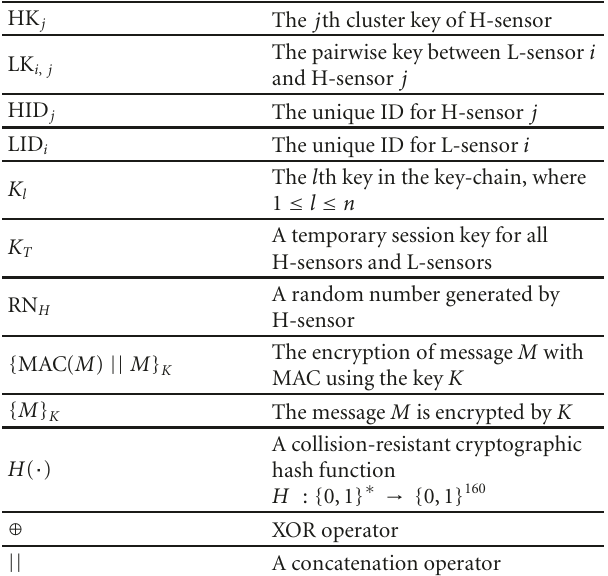
Table 1: The definition of the